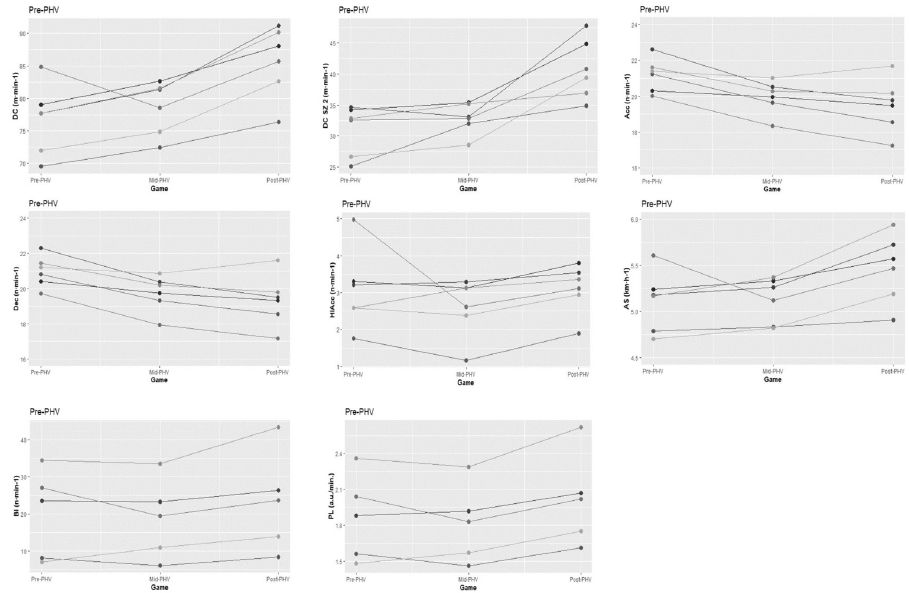
Fig 2. Individual graphical representation of significant differences in physical and tactical performance between game formats amongst Pre-PHV athletes.